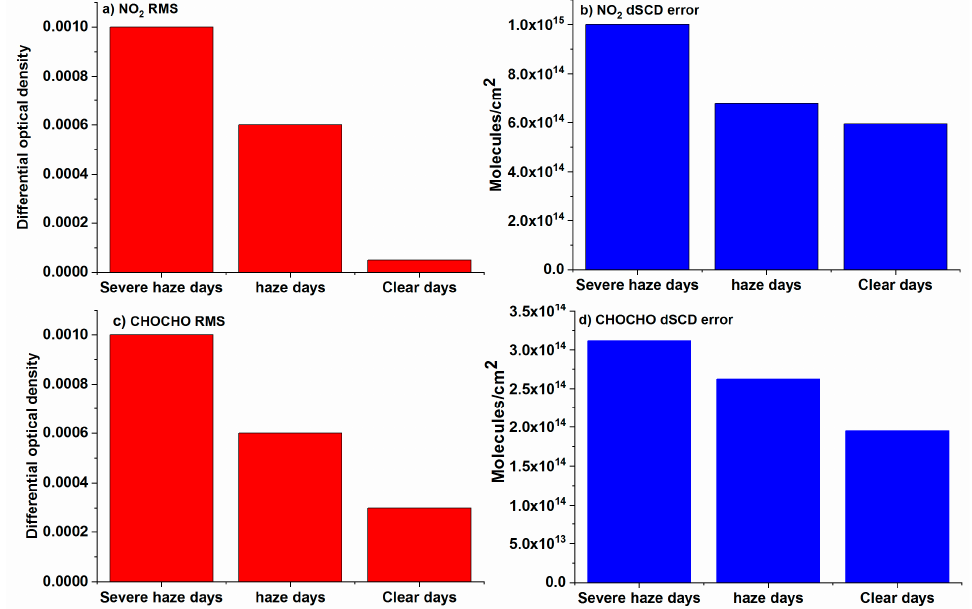
Figure 3. ( a ) NO 2 RMS ( b ) NO 2 dSCD error, ( c ) CHOCHO RMS and ( d ) CHOCHO dSCD error under different weather conditions.